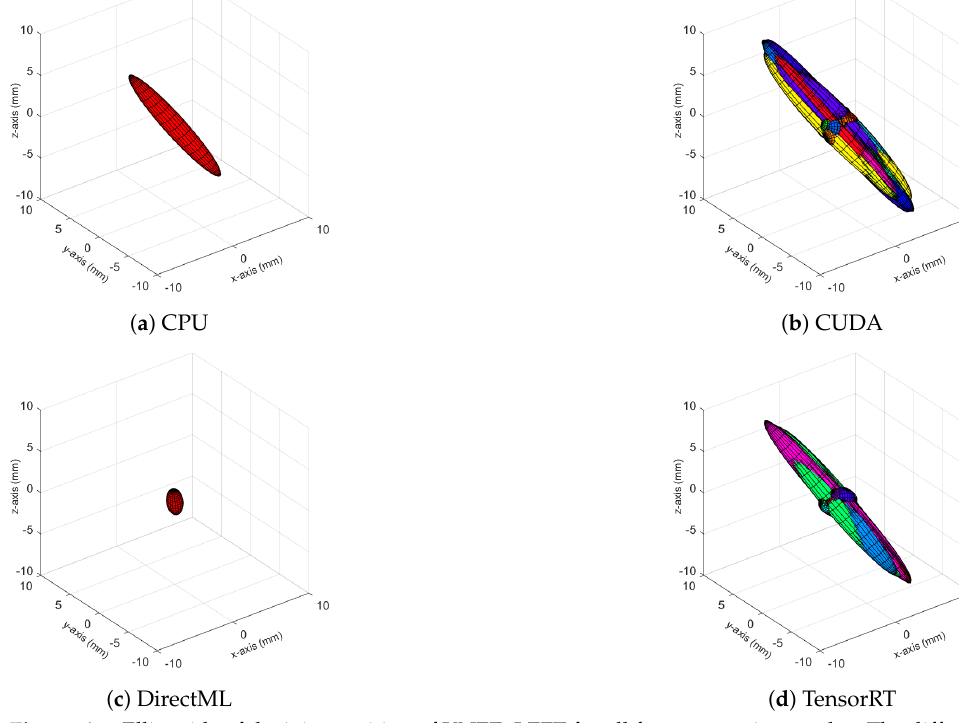
Figure A4. Ellipsoids of the joint position of KNEE_LEFT for all four processing modes. The different colors represent different body tracking runs.